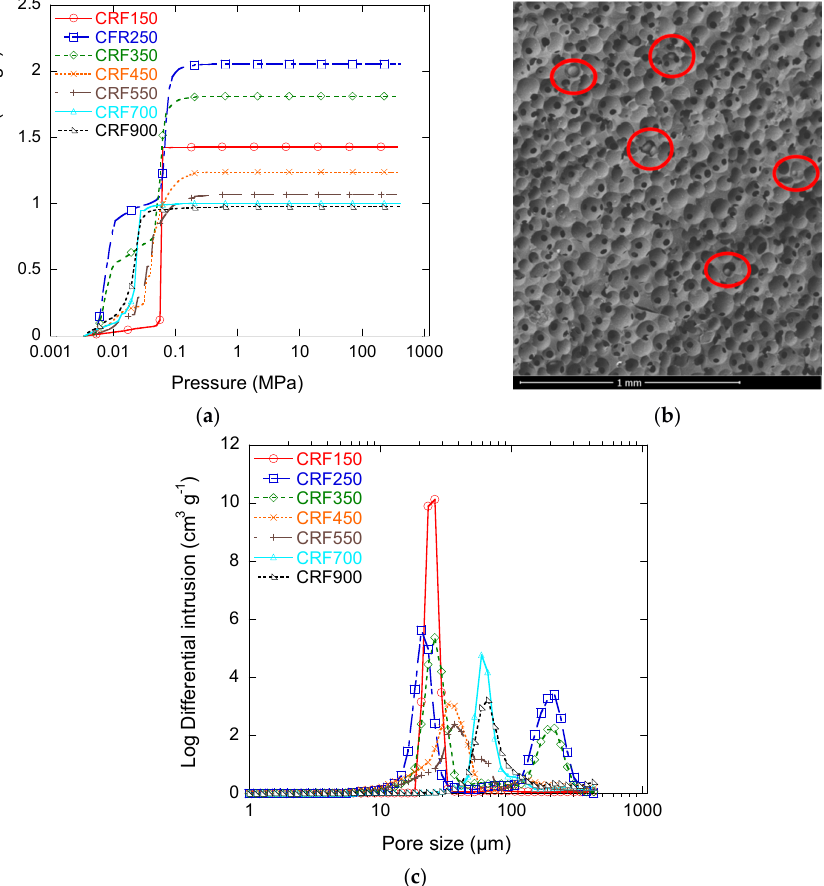
Figure 6. ( a ) Mercury intrusion curves of all cellular carbon monoliths; ( b ) SEM pictures with BSE detector of CRF150 sample: cells filled with carbon spheres are highlighted by red circles; ( c ) pore size distributions derived from ( a ).